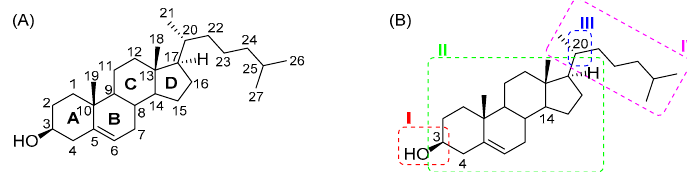
Figure 1. ( A ) Numbering and ring-labeling convention in cholesterol; ( B ) four domains of cholesterol.